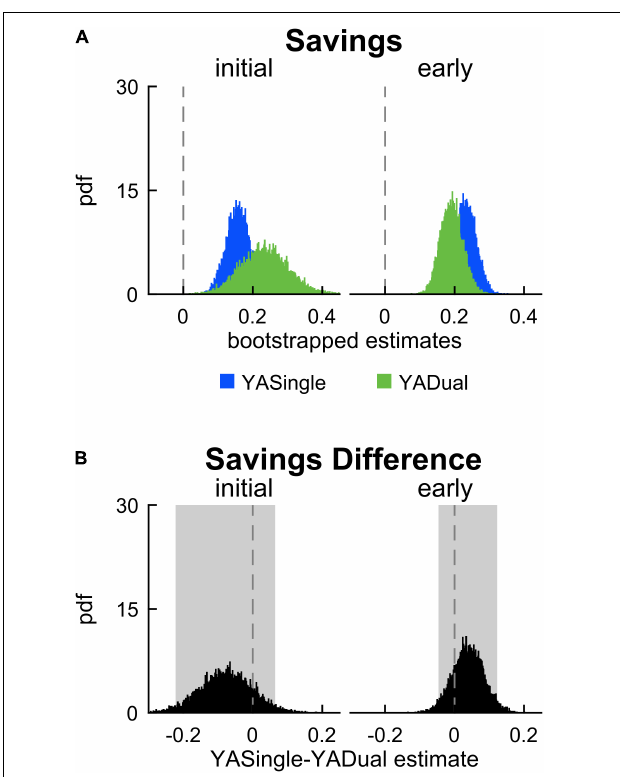
FIGURE 4 | Savings in single- and dual-tasking young adults. (A) PDF of savings (difference in step length asymmetry between readapt and adapt) during the initial (strides 1–5) and early (strides 6–30) time epochs, for single-tasking (YASingle, blue) and dual-tasking (YADual, green) young adults. (B) PDF (and shaded 95% CI) of the difference of the means between YASingle and YADual for savings measures. PDFs and CIs were obtained through bootstrapping. Savings was not different between single- and dual-tasking young